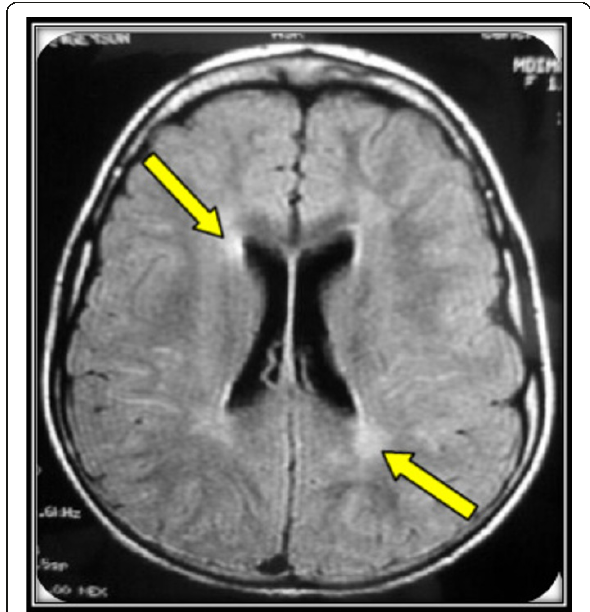
Figure 2 Brain MRI of the patient with late infantile form of MLD .